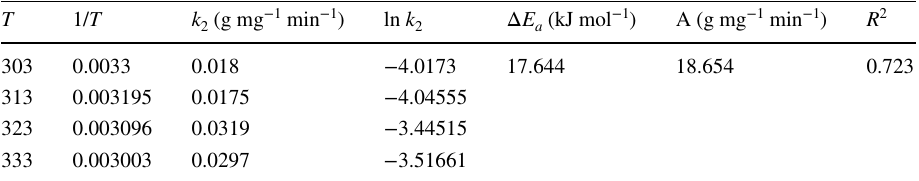
for adsorption of MB onto nZVAl nanoparticles ([MB] = 30 mg/L; nZVAI dosage = 1 g/L) at different